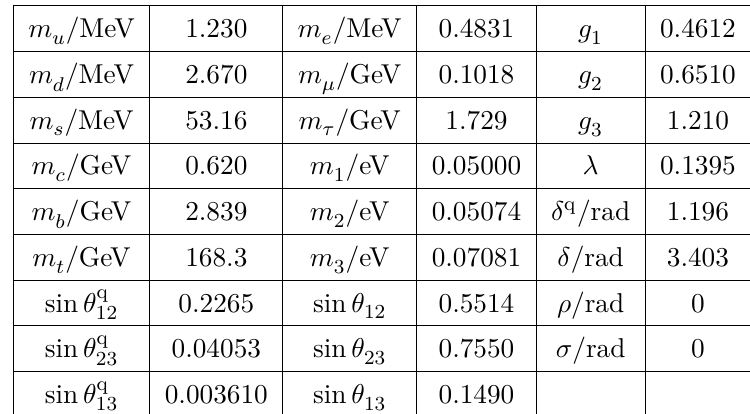
, θ q , θ q , δ q } refer to those in the quark 12 13 23 (for i = 1 , 2 , 3 ) and the quartic i